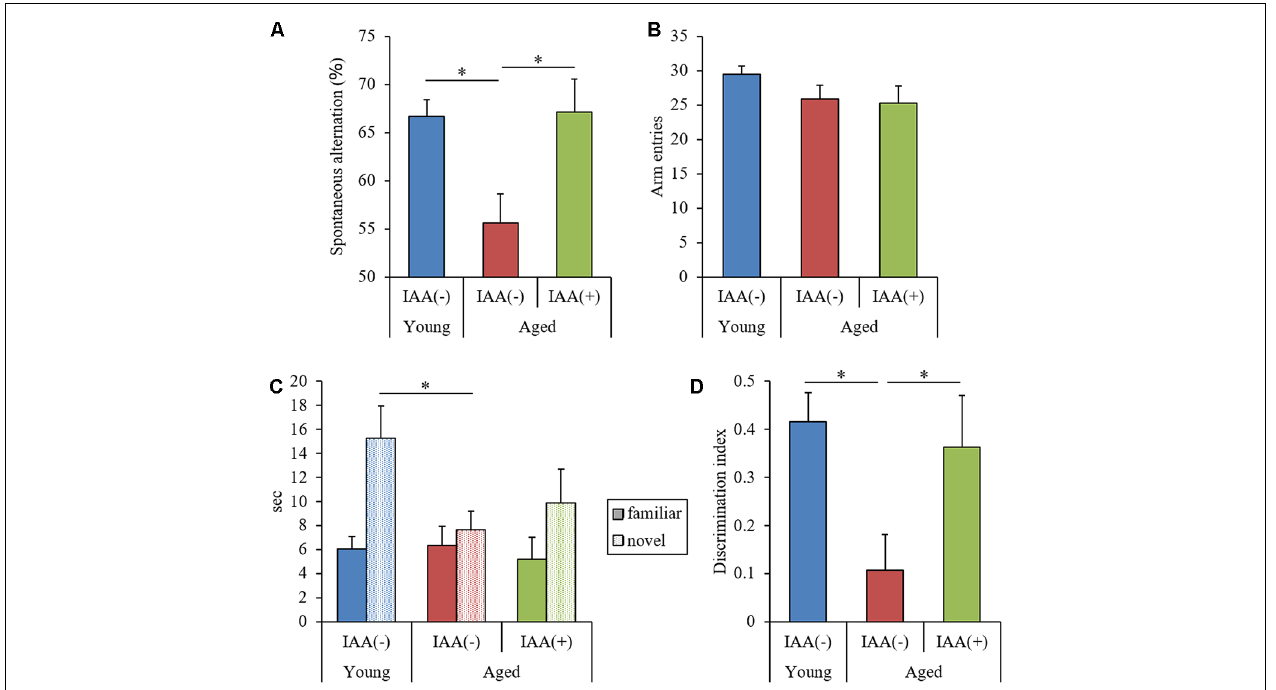
FIGURE 1 | Behavioral evaluation of cognitive functions. We fed C57BL/6J mice aged 7 weeks (young) and 68 weeks (aged) diets containing 0% or 0.05% (w/w) Iso- α -acids (IAA) for 3 months. We then performed behavioral evaluation in young mice ( n = 12) and aged mice with ( n = 10) or without ( n = 9) dietary IAA. (A,B) We evaluated spatial memory using a Y-maze spontaneous alternation test to measure spontaneous alternation score (A) and total arm entries (B) . (C,D) We evaluated object recognition memory using a novel object recognition test (NORT). We measured the time taken to approach a novel or familiar object (C) and the discrimination index (DI) in NORT (D) . Data are presented as mean ± standard error of the mean (SE). We calculated p -values shown in the graph by one-way analysis of variance (ANOVA), followed by the Tukey-Kramer test. ∗ p < 0.05.